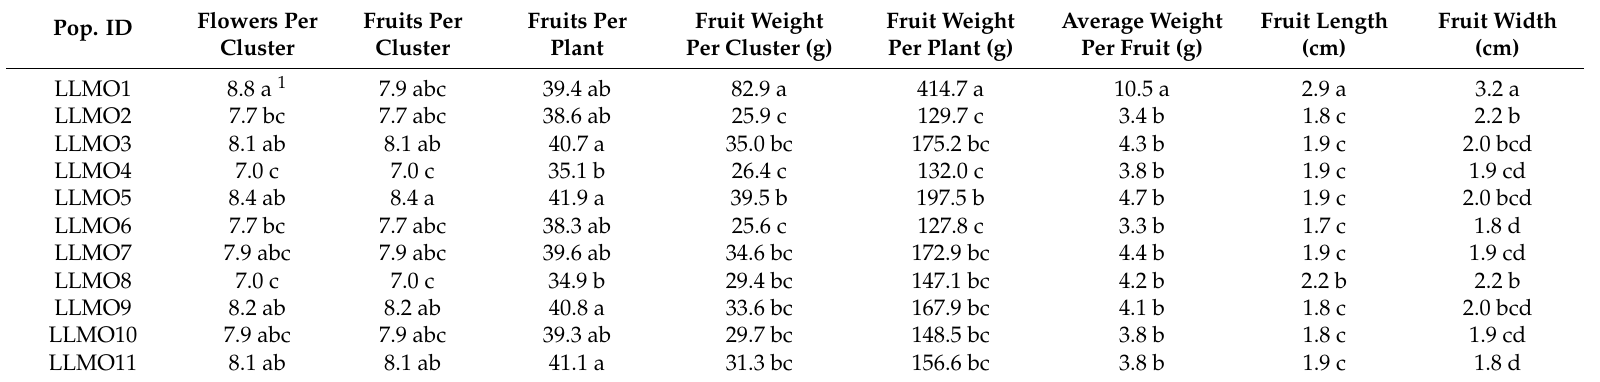
Table 4. Means comparison of flowers and fruits per cluster in eleven tomato accessions from El